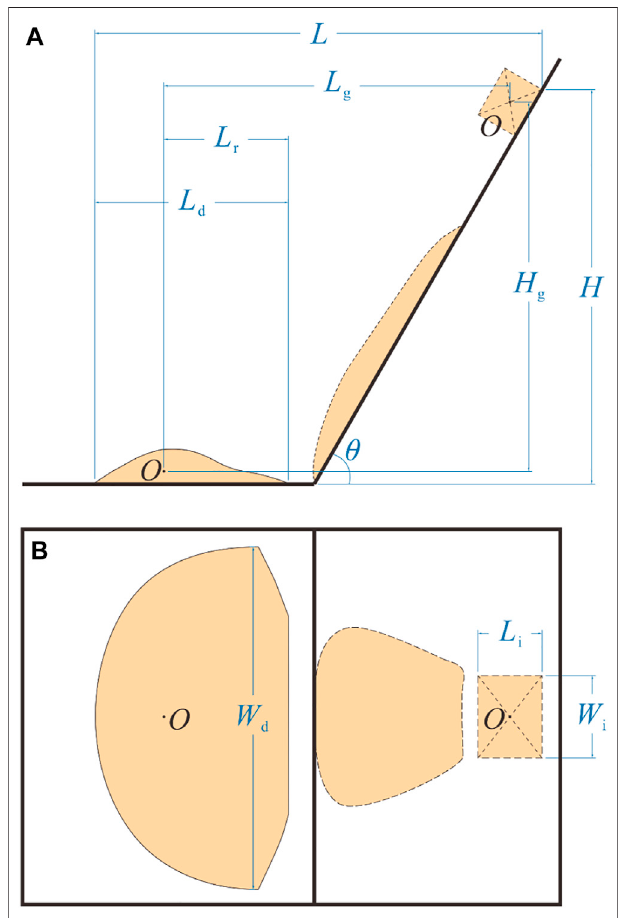
FIGURE4| Diagramofthevariablesinvolvedinthelandslideprocess (A) Pro fi le (B) Planform.